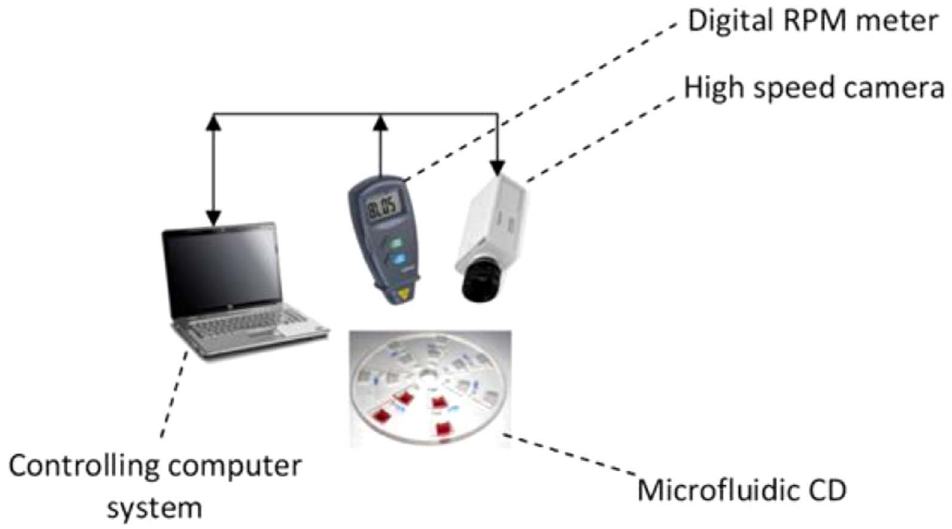
Figure 2. Experimental setup: controlling computer system connected to high speed camera and a digital rpm meter.